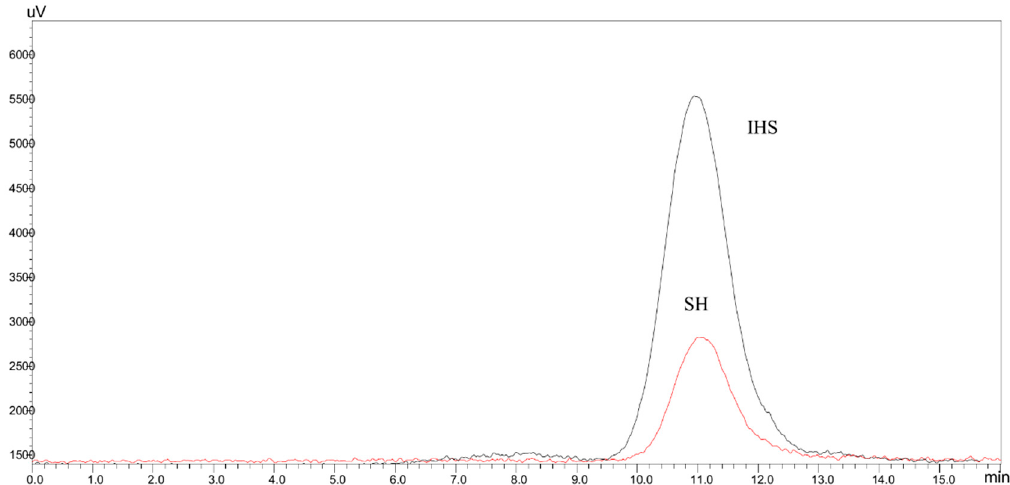
Figure 3. SEC-HPLC chromatograms of the hydrolysis products of the soluble (SH) and insoluble (HIS) fractions of DL.